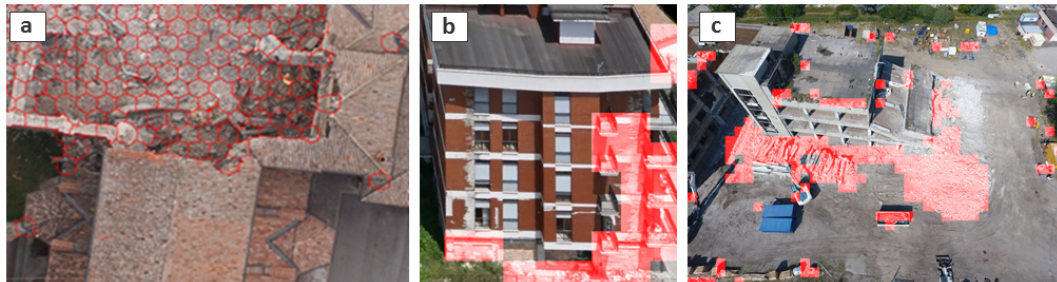
Figure 7. Examples of damage detection on images acquired in three different scenarios: (a) Mirabello (source: Vetrivel et al., 2017), (b) L’Aquila and (c) Lyon (source Duarte et al.,